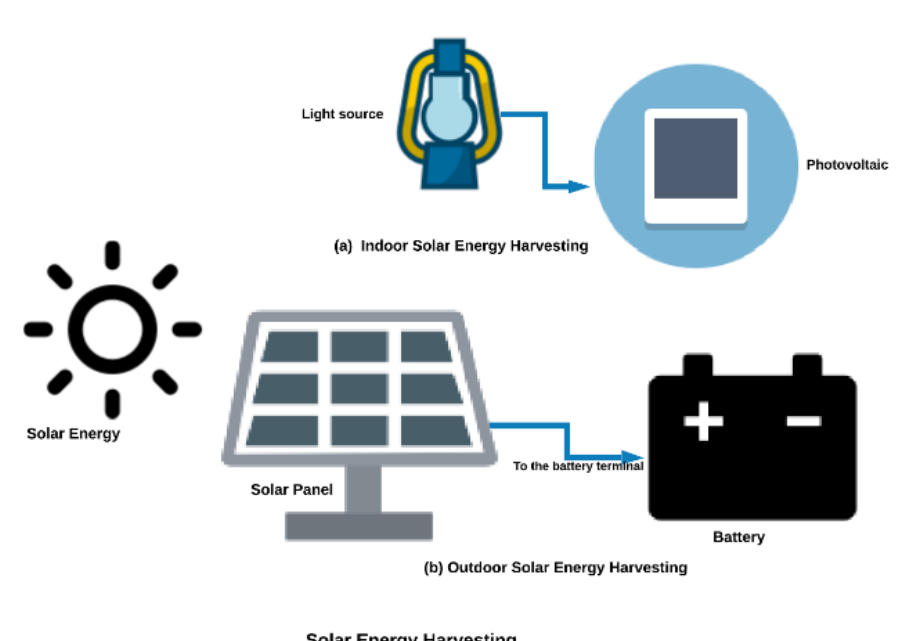
Figure 10. Solar Energy